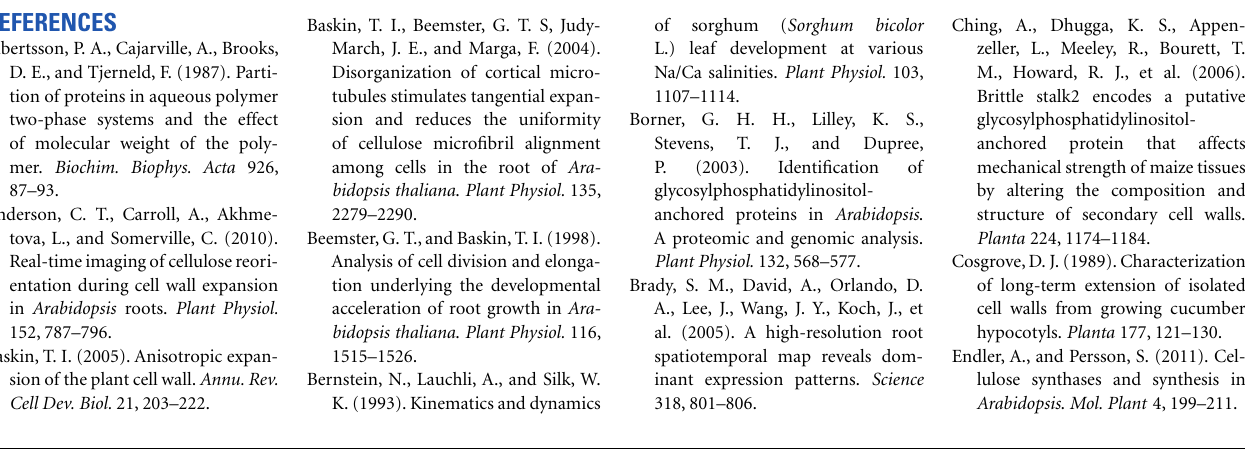
Table S1 | Complete list of all raw and normalized spectral counts for proteins identified in this